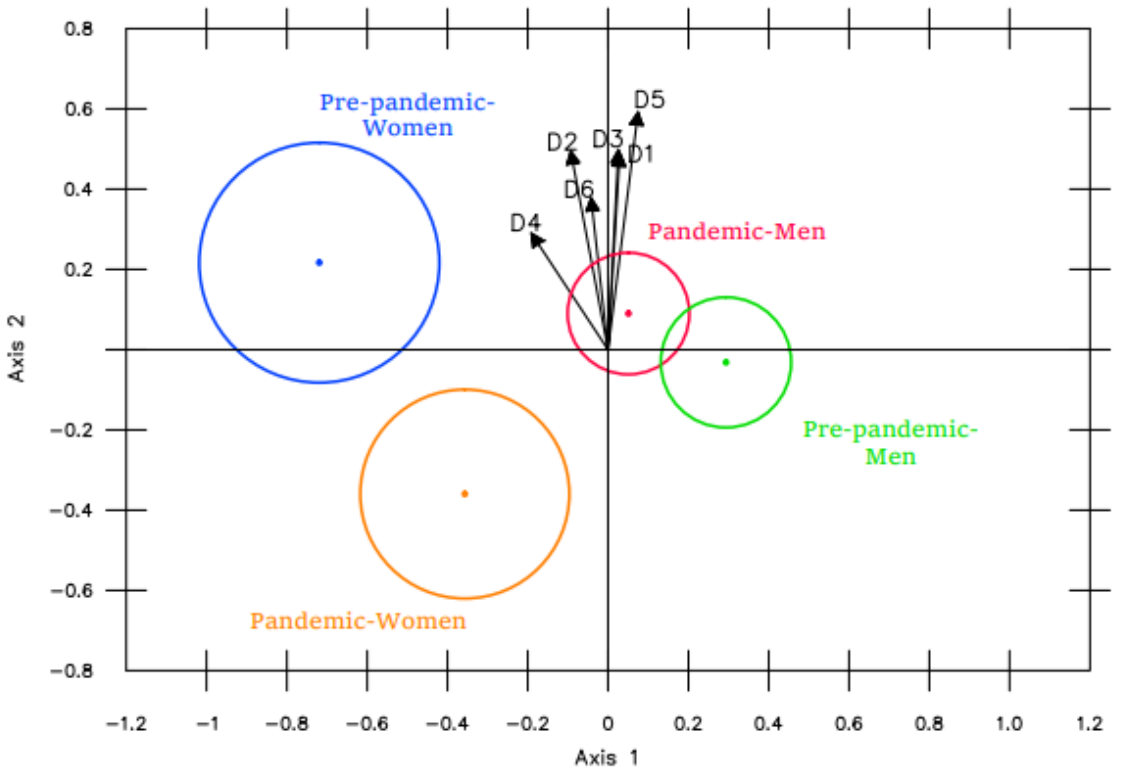
Figure 9. Representation of pre-pandemic/pandemic groups vs. gender. Figure 8. Representation of pre-pandemic/pandemic groups vs.